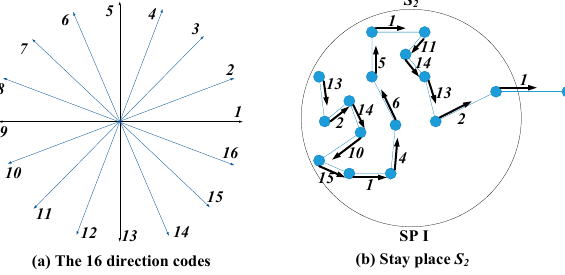
Figure 4. An example of the direction-code sequence within a stay place. ( a ) shows the partition of 16 direction code regions. ( b ) shows the direction code of each trajectory segment within the area of S 2 .